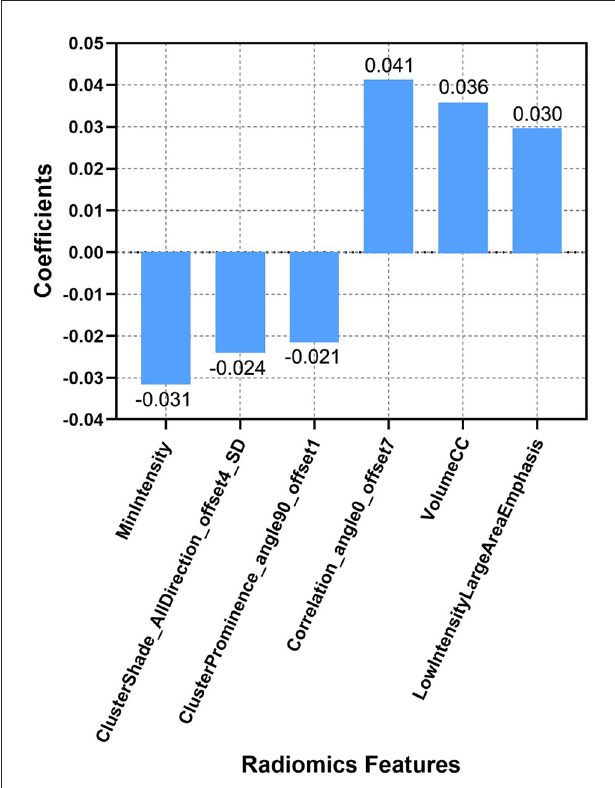
FIGURE2 Descriptions of the six optimal radiomic features used to calculate the Rad-score. The x -axis represents the individual radiomic features, with their coefficients in the LASSO regression analysis plotted on the y